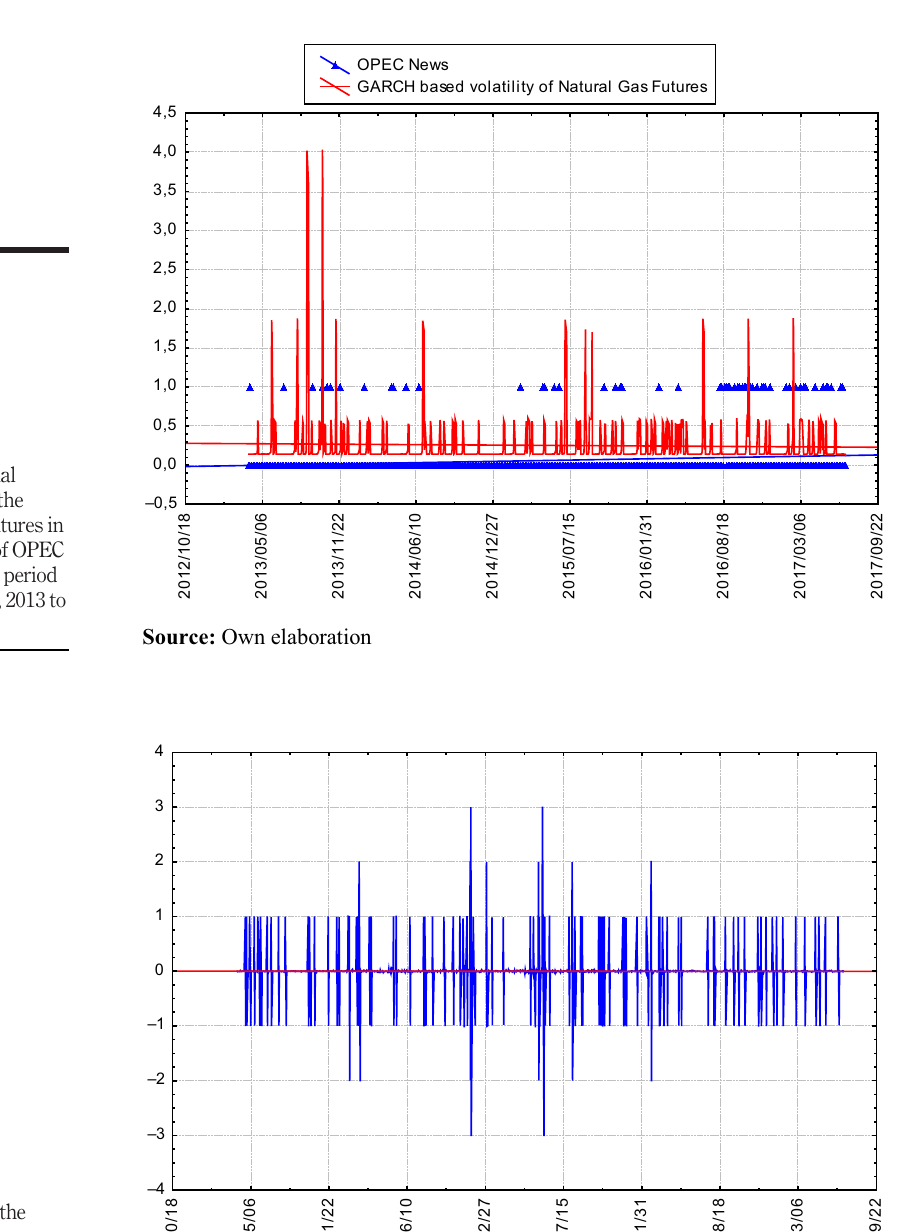
Figure 11. The return of the heating oil futures over the period